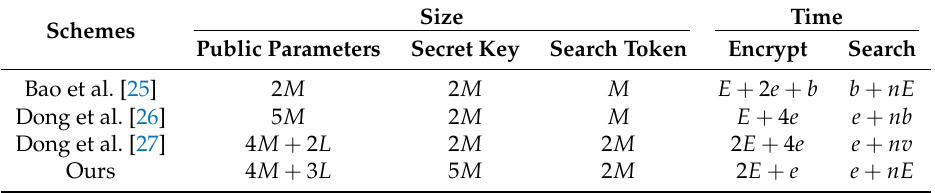
Table 4. Performance comparison of several multi-user searchable encryption schemes. Size Time Schemes Public Parameters Secret Key Search Token Encrypt Search Bao et al. [25] 2 M 2 M 5